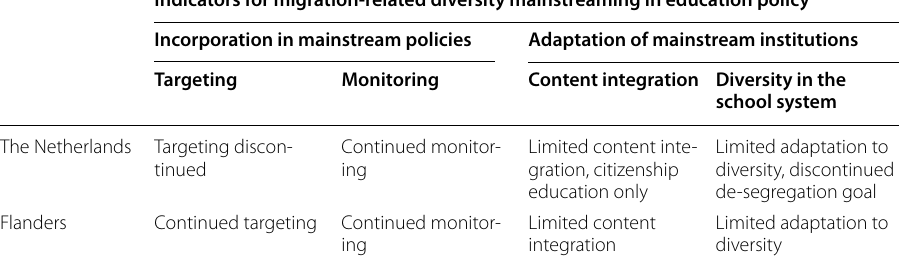
Table 1 Comparative findings for migration-related diversity mainstreaming in Dutch and